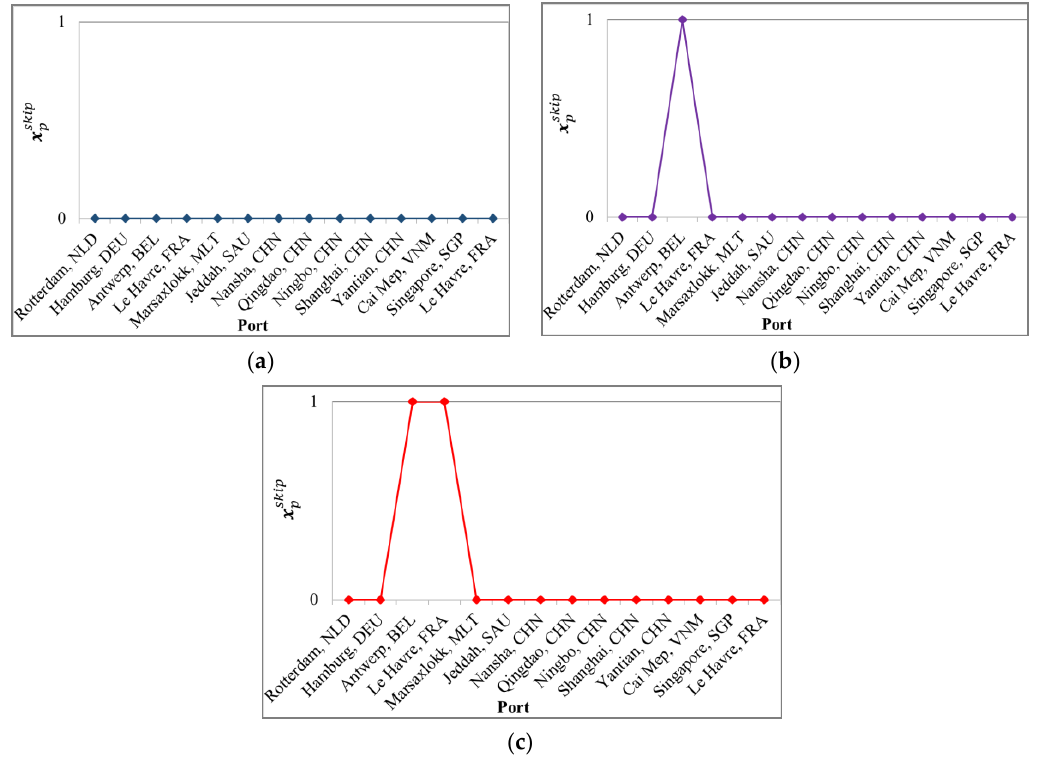
Figure 6. The port skipping decisions for the considered disruption cases: ( a ) disruption case 1; ( b ) disruption case 2; and ( c ) disruption case 3.